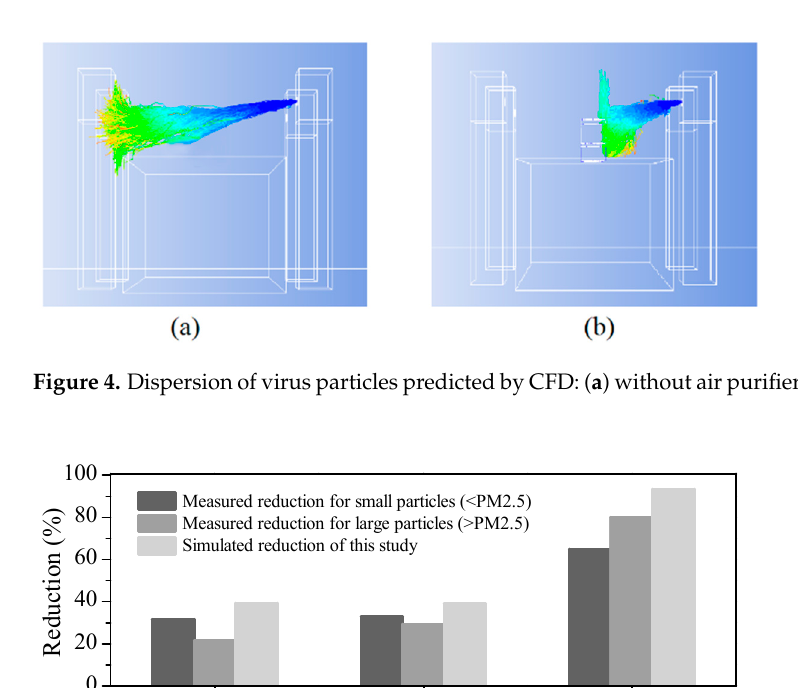
i th points ( i = 1, 2, 3) for the case with air purifiers. Figure 5 compares the results obtained from the simulation and test. Figure 4. Dispersion of virus particles predicted by CFD: ( a ) without air purifier; ( b ) with air puri- fiers.